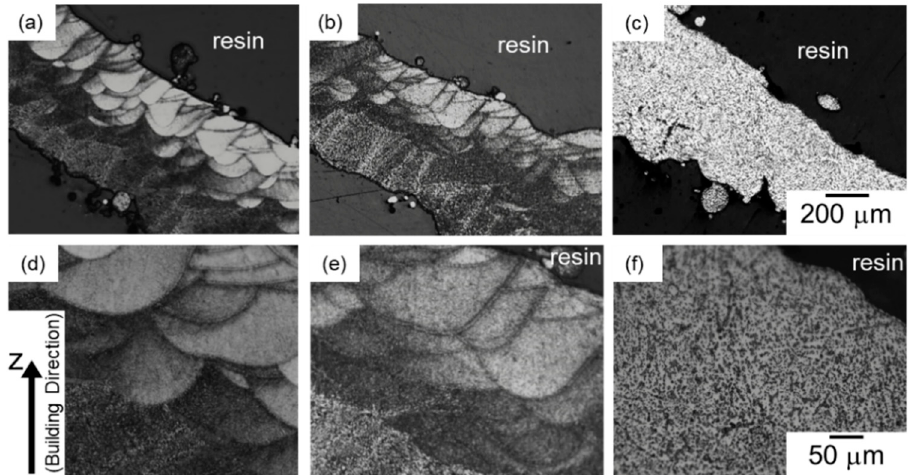
Figure 9. Optical micrographs of microstructures taken from the strut portion of the lattice specimen at ( a − c ) low magnification and ( d − f ) high magnification: ( a , d ) as-manufactured, ( b , e ) annealed at 300 °C for 2 h, and ( c , f ) solution heat treated at 530 °C for 6 h.